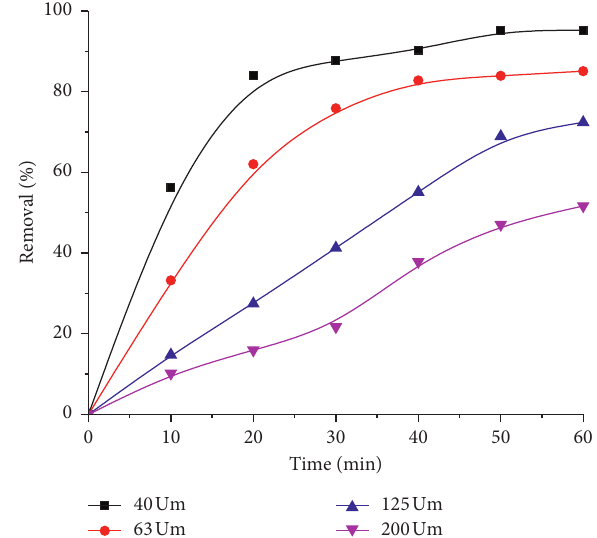
Figure 5: MB removal at different particle